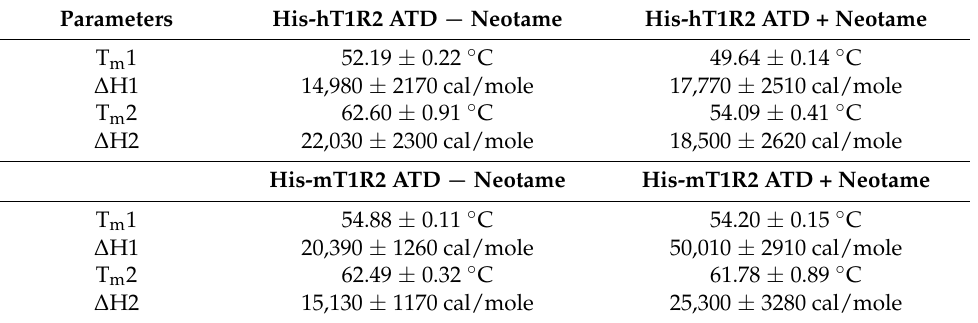
Table 2. Summary of DSC measurements for the apo and neotame bound states of human and mouse ATD